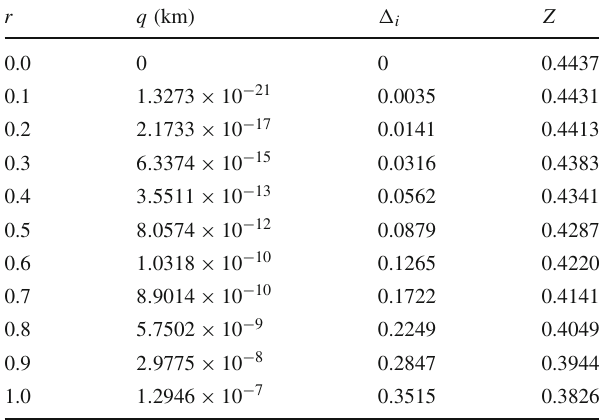
Table 3 Values of charge, anisotropy and redshift for n = 1, m = 5, N = 11, a = 1, b = 0 . 25, K = 0 . 11, β = 4 . 2395. The related plots